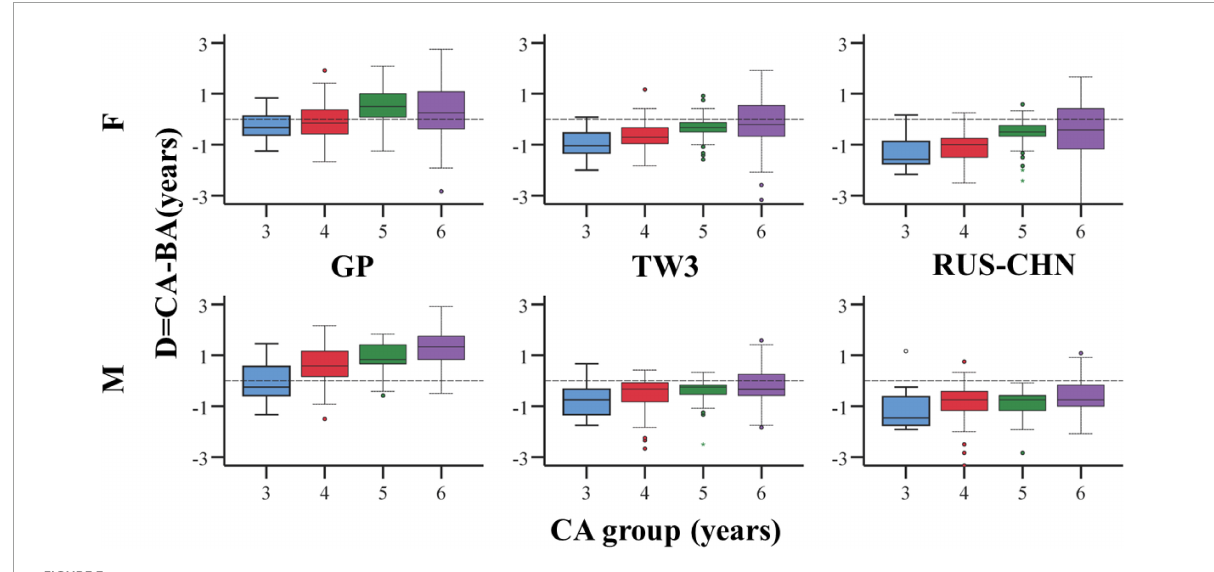
FIGURE3 Boxplots of D = CA - BA reported for females (top) and males (bottom) for the three methods and each class of age.